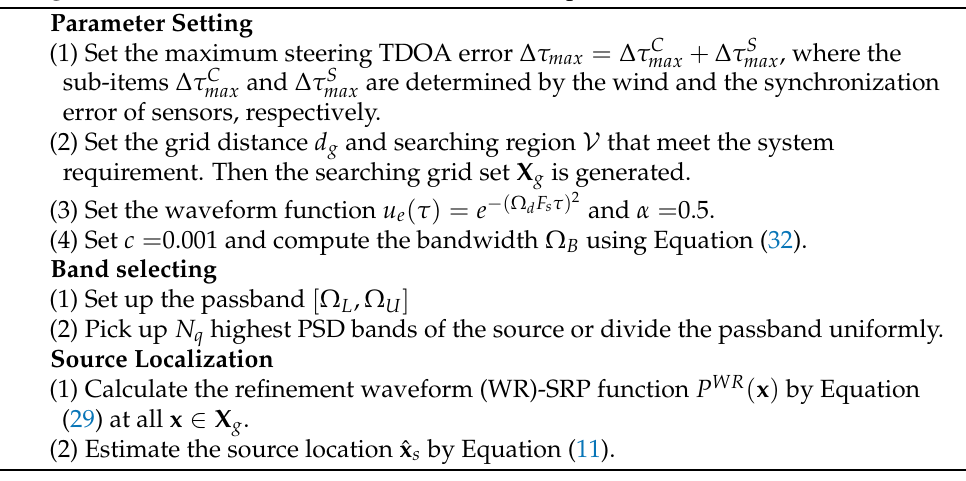
Algorithm 1: SRP with the waveform refinement procedure Parameter